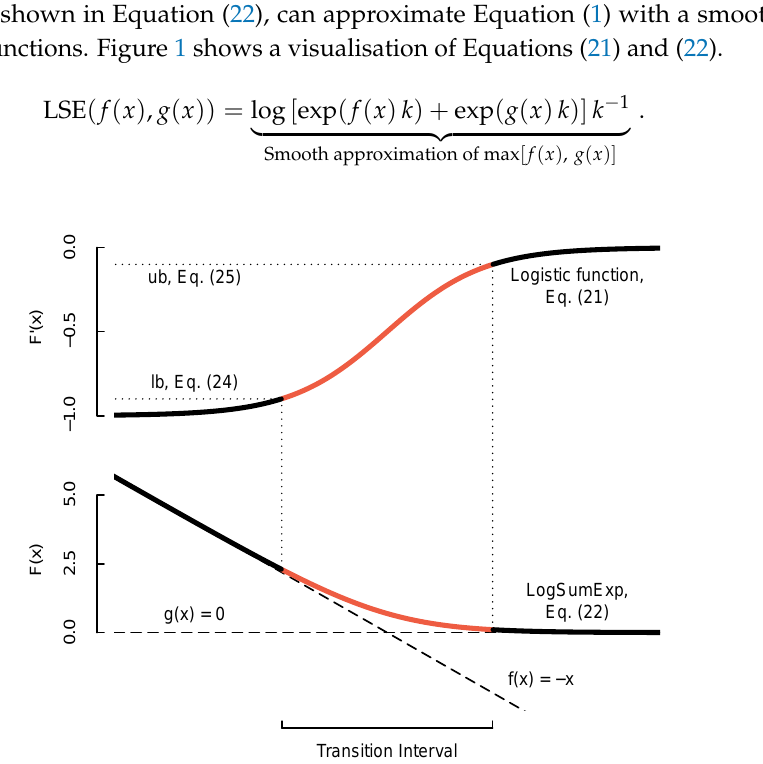
Figure 1. Conceptual diagram of transition interval definition. The thick black and red lines in the lower plot show the smooth maximum approximation of f ( x ) = − x and g ( x ) = 0 obtained by the LogSumExp function. The upper plot shows the slope (i.e., the logistic function) of the LogSumExp function. From the logistic function the start and end of the transition interval between f ( x ) and g ( x ) is obtained by ub (upper bound) and lb (lower bound) indicated by the horizontal dotted lines and the intersection with the logistic